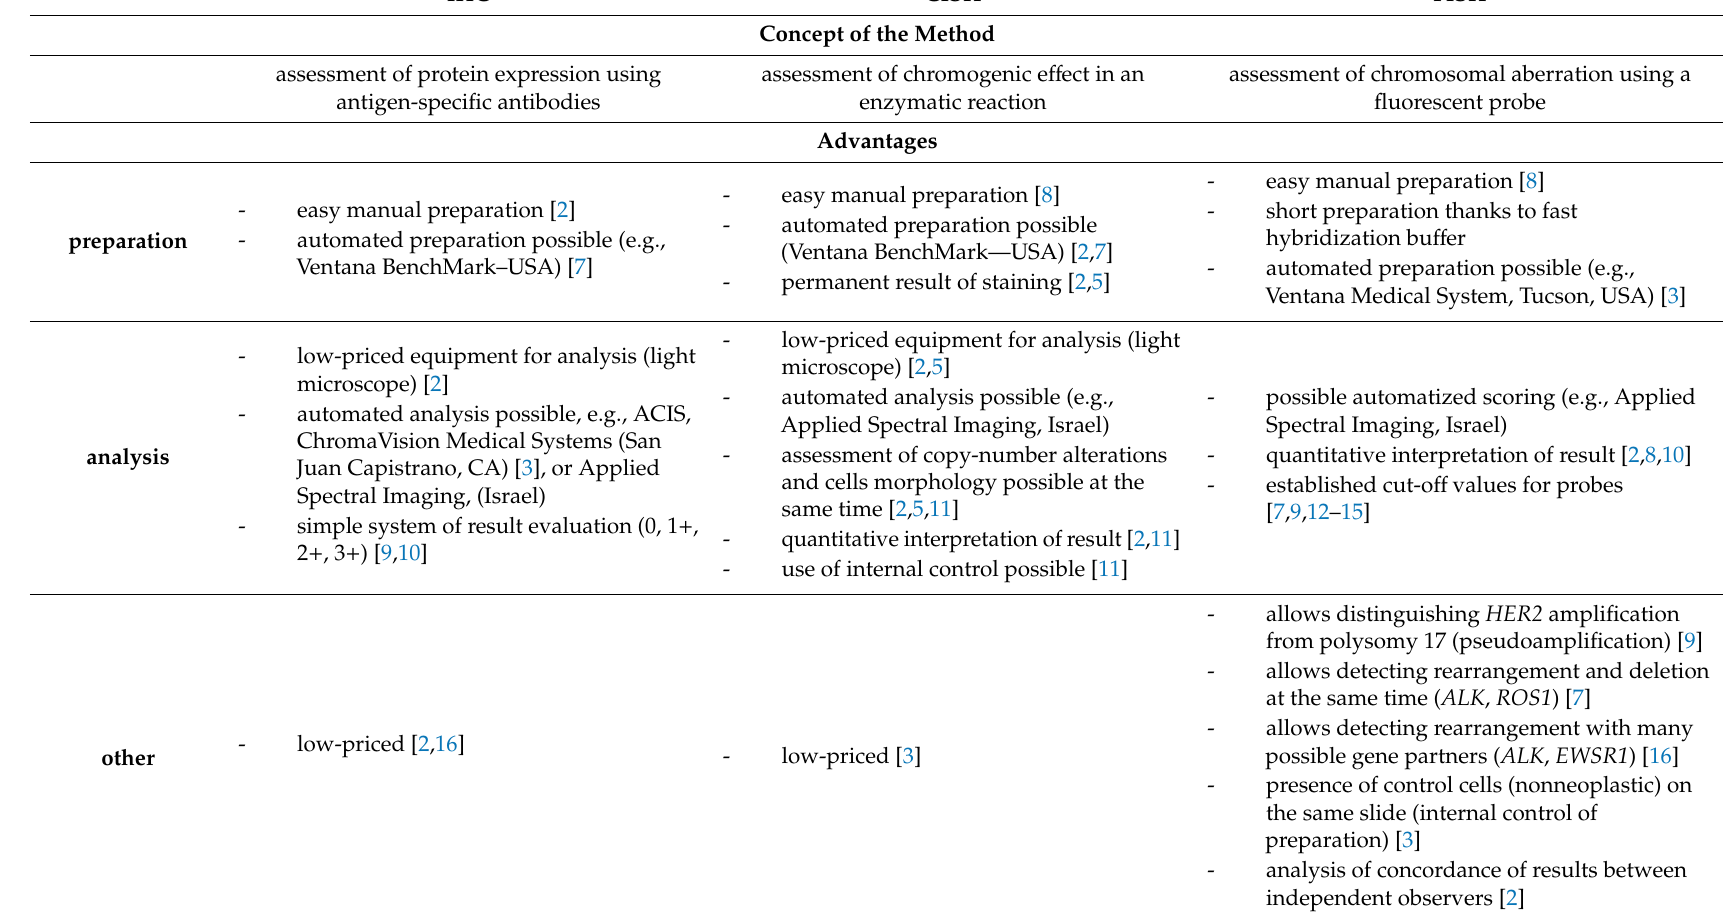
Table 1. Comparison of immunohistochemistry (IHC), chromogenic in situ hybridization (CISH) and fluorescence in situ hybridization (FISH)